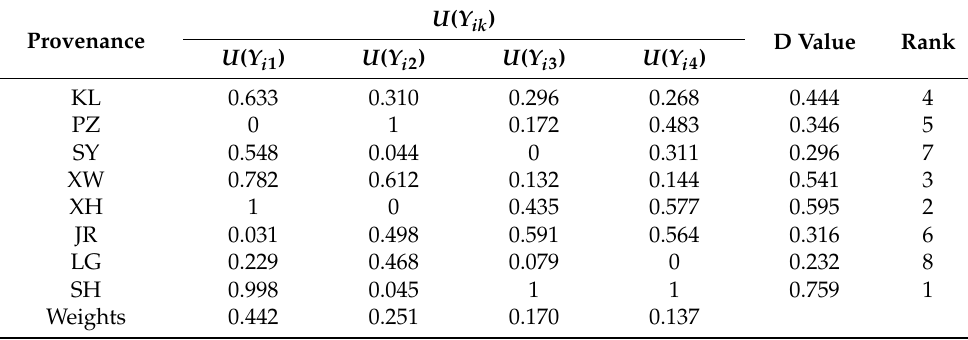
Table 11. The function value of the comprehensive indexes ( U ( Y ik )), weight ( W k ), and the compre- hensive evaluation value (D) of the different provenances under severe drought